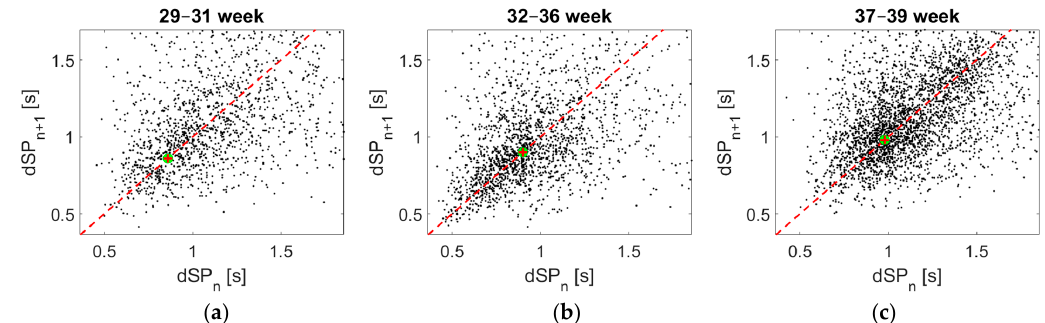
Figure 5. The time intervals of the FBM episodes in the well-known Poincaré-type recurrence plot according to the differ- ent gestational ages (see a – c ). The distances of two neighboring starting points (dSPs) are very diverse, which became more and more homogeneous at the end of the last trimester.